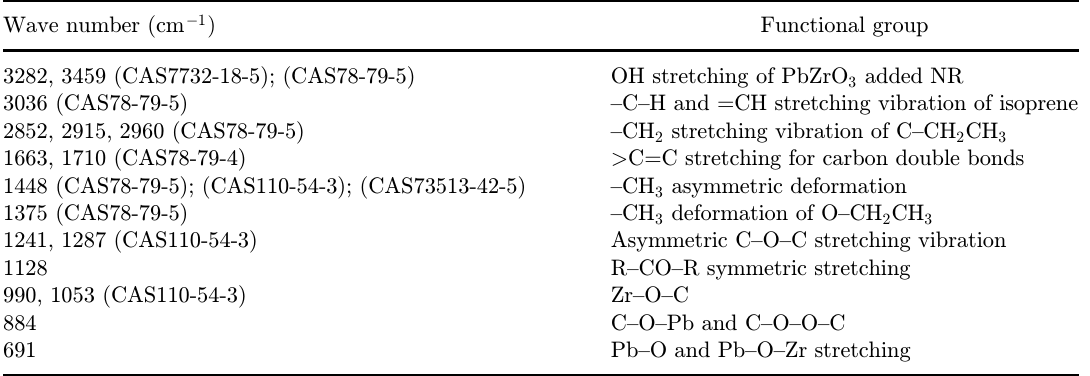
Table 1. FTIR spectra of natural rubber (NR-STR 5L), lead zirconate (PbZrO 3 Þ , and NR-STR 5L/PbZrO 3 composite materials.